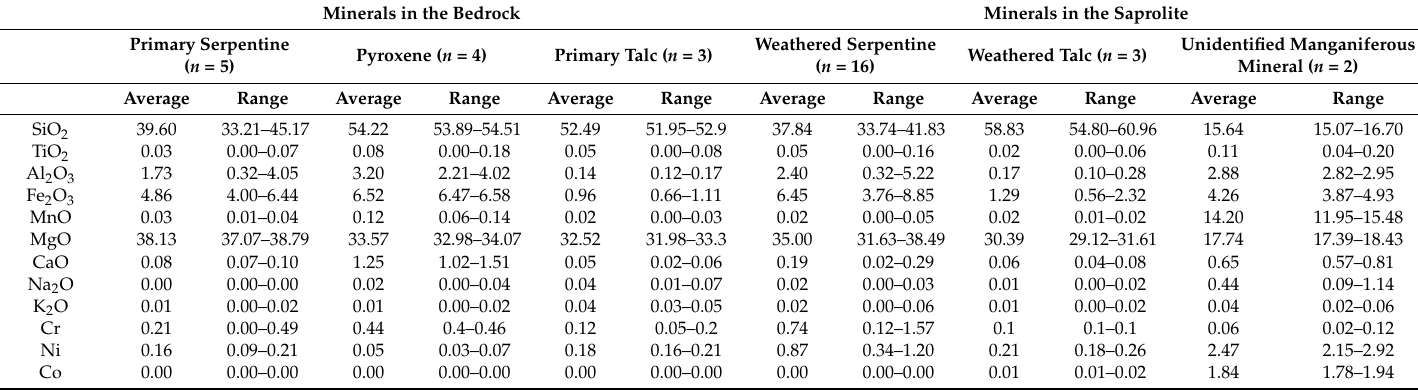
Table 2. Electron microprobe analyses data of the primary and weathered minerals in the Yuanjiang Ni laterite profile (wt